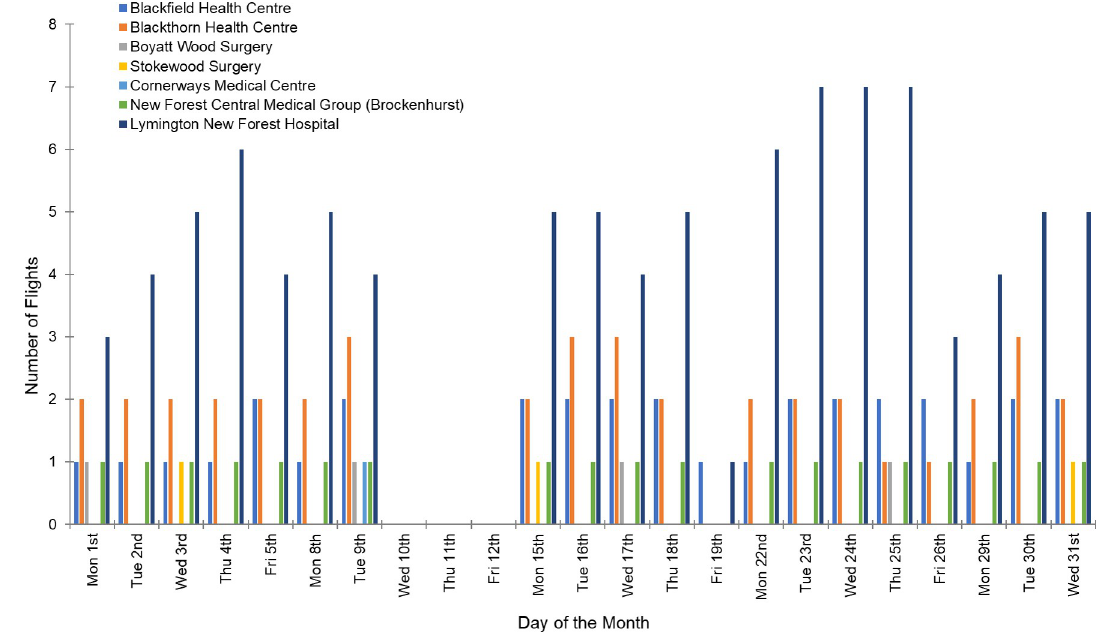
Fig 10. Number of flights per day for the UAV collection service during March